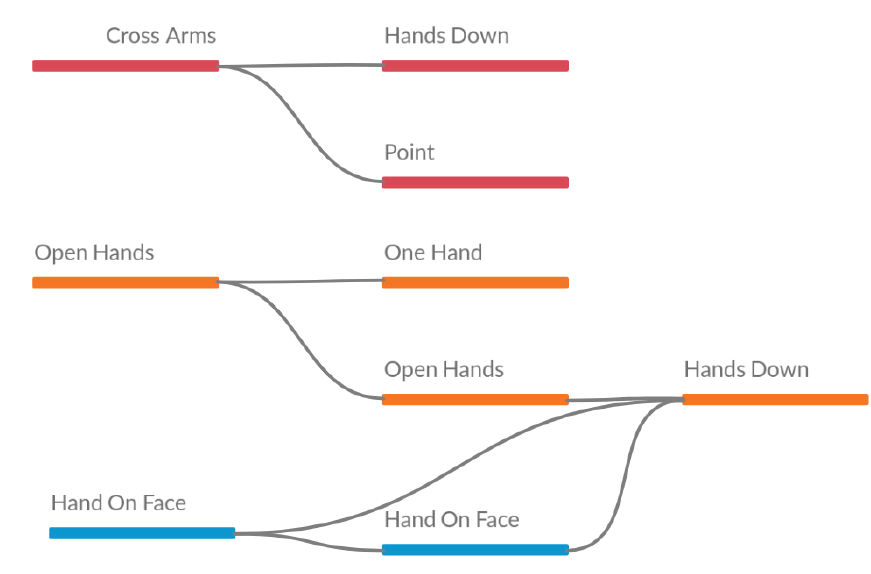
Figure 12. Visual representation of sequences from presentation 3 of year